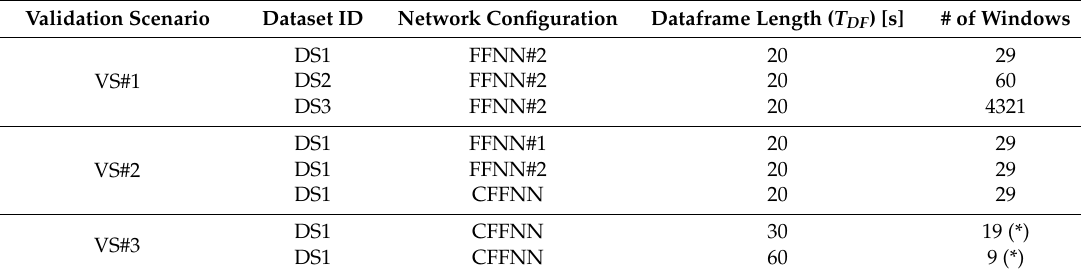
Table 3. Validation scenarios: datasets and ANN configurations.